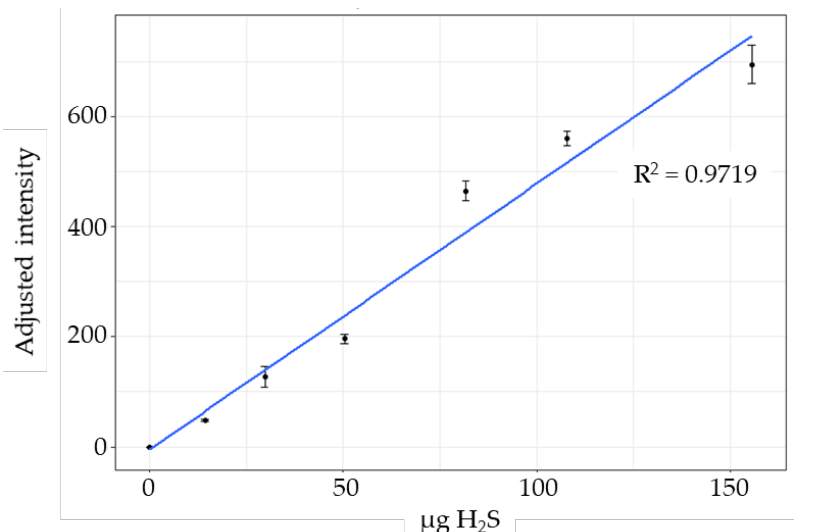
Figure 7. Total H 2 S production in presence of different assimilable nitrogen (colors) and sulfur dioxide ( x axis) content for each strain.